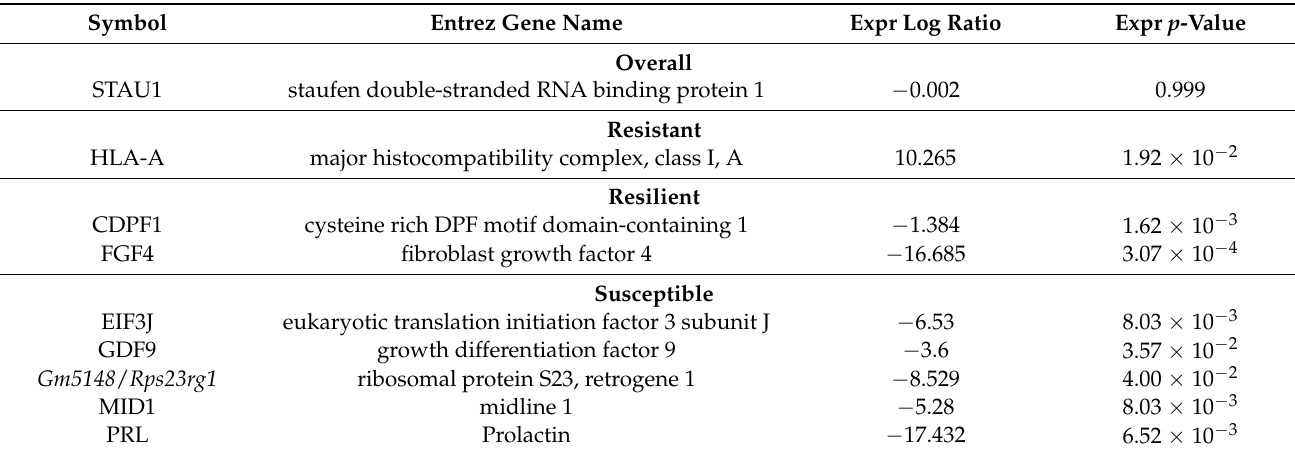
Table 3. Unique biomarkers representing 3 distinct TMEV response profiles were identified from expression data of strains in each